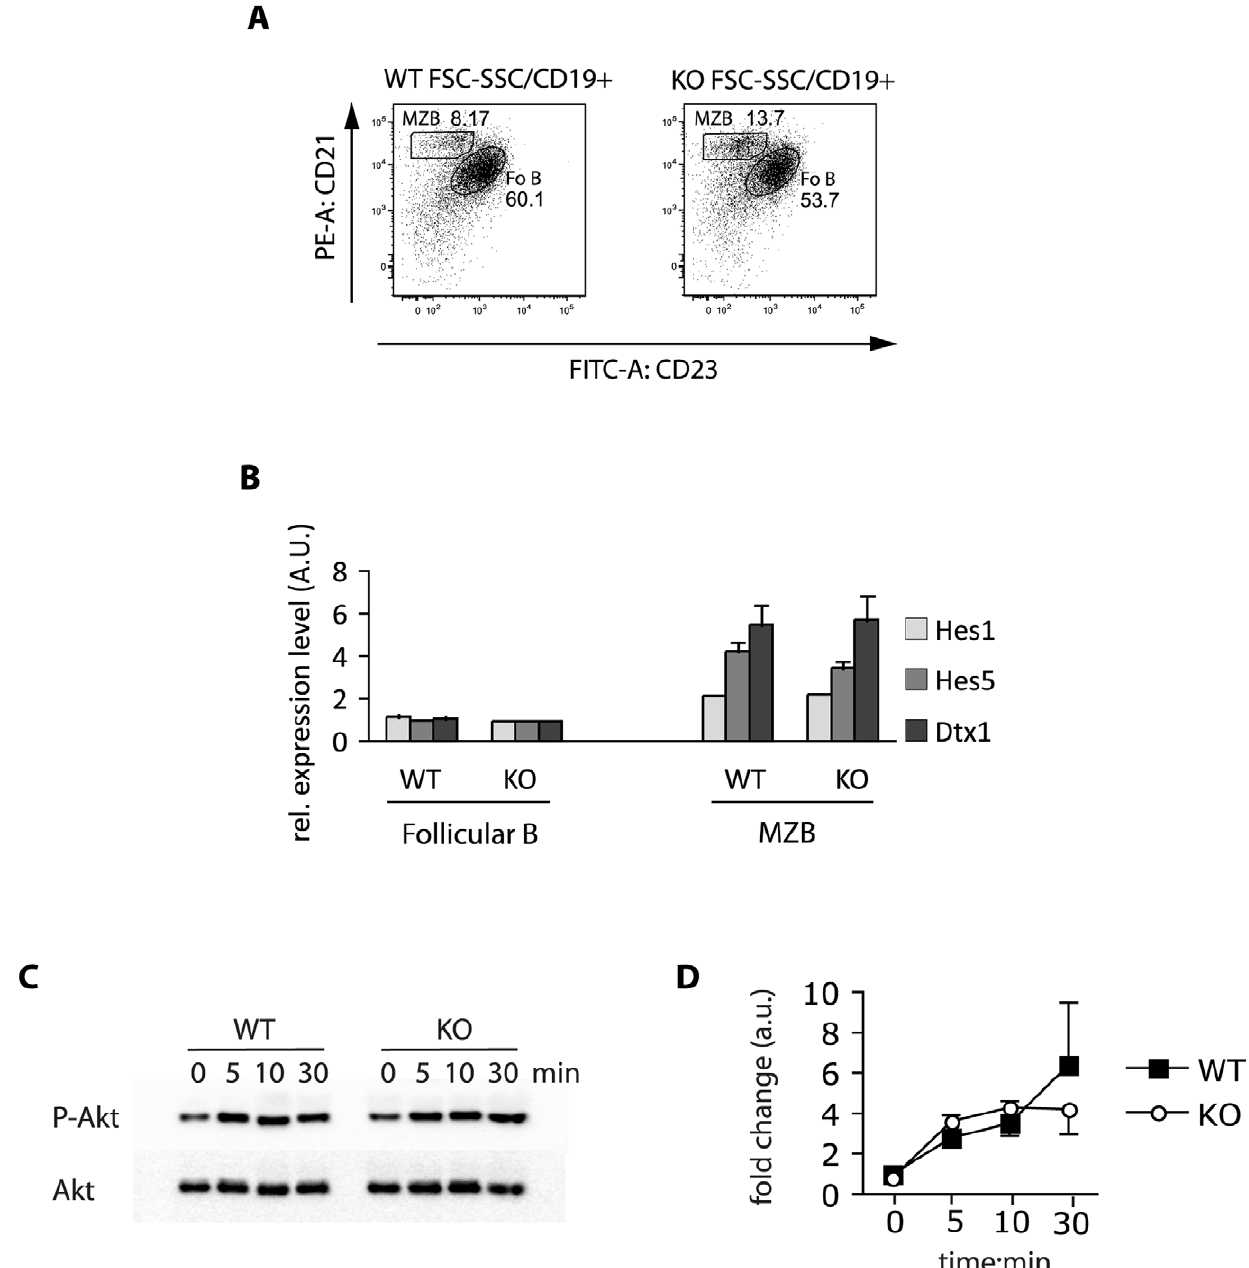
Figure 5. The increase in the MZB cell population in Eps15-KO mice is cell autonomous. A. Scheme depicting the experimental design of the reverse bone marrow transplantation. Bone marrow cells from Eps15-WT or Eps15-KO mice were transplanted into sub-lethally irradiated Eps15- WT or Eps15-KO mice. B. Dot plot depicting the efficiency of CD45.1 + WT donor cell engraftment in either Eps15-WT or Eps15-KO CD45.2 + recipient mice. Gating CD19 + splenocytes for CD45.1 and CD45.2 expression revealed more than 99% engraftment of donor cells in both types of host. C. PCR genotyping of peripheral blood 2 months after bone marrow transplantation. In mice injected with Eps15-WT cells the resulting genotype is WT, independent of the recipient genotype. Similarly, in mice injected with Eps15-KO cells the resulting genotype is KO, independent of the recipient genotype. ‘M’ indicates marker. D. Western blot analysis of splenocyte lysates 3 months after bone marrow transplantation. The membrane was decorated with anti-Eps15, or anti-vinculin as a loading control. The Eps15-specific bands are indicated by arrows. E. Dot plot of splenocytes 3 months after bone marrow transplantation. Splenocytes were stained for CD19, CD21 and CD23 to identify Fo B (CD19 + /CD21 + /CD23 + ) and MZ B (CD19 + /CD21 + /CD23 2 ) cells for each combination of genotypes. F. Bar graph depicting the total number of CD19 + /CD21 + /CD23 2 MZ B cells for each genotype combination (n=6). The significance was calculated using the Student’s t-test and is reported in the table below the graph.